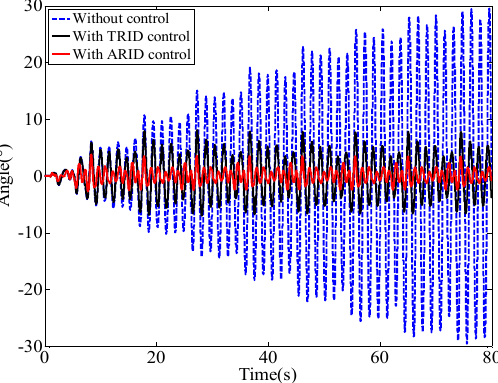
Figure 12. Numerical results of the swing angle of the structure with the TRID or ARID system.